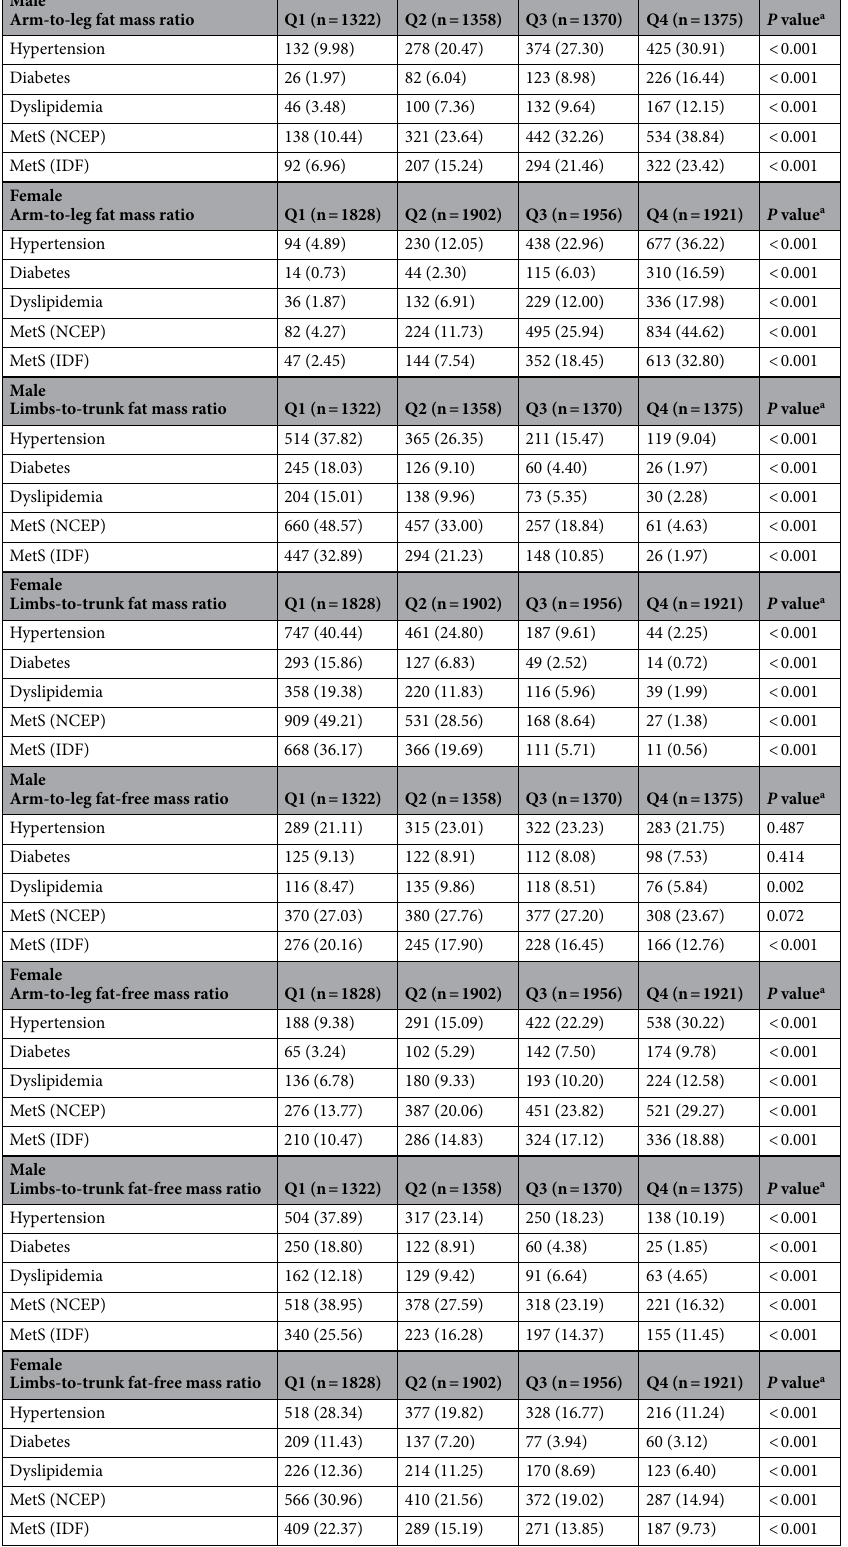
Table 2. Prevalence of cardiovascular disease risk factors according to body composition ratio quartile. MetS, metabolic syndrome; NCEP, 2005 National Cholesterol Education Program Adult Treatment Panel III; IDF, 2006 International Diabetes Federation. Data are presented as numbers (%). a P value from χ 2 test for categorical variables, comparing differences among four